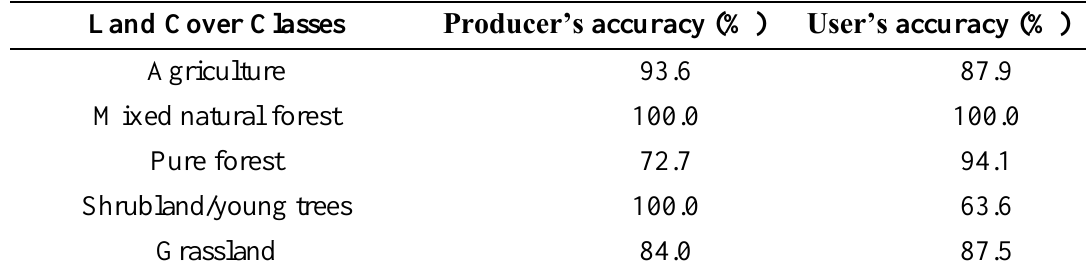
Table 3. The accuracy level of each true LC